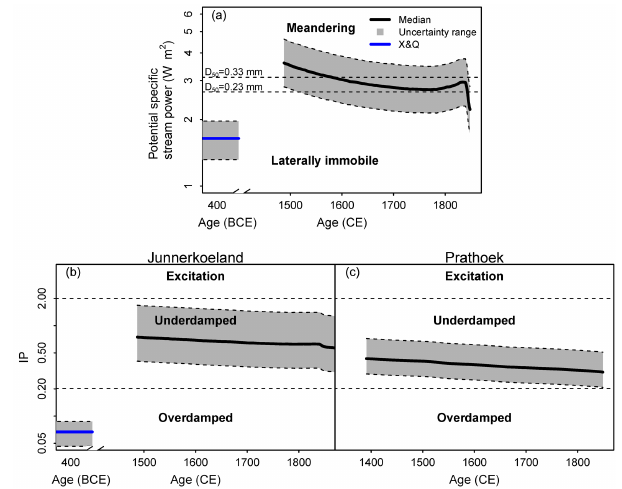
Figure 11. The potential for meandering with time. (a) The po- tential specific stream power in a stability diagram (Eq. 11). Two discriminators were plotted for a range of median particle sizes of the bed sediment, which is the range of particle sizes found in the scroll bars and Palaeochannels X and Q (Fig. 6). Panels (b) and (c) show the bar regime for both Junnerkoeland and Prathoek, de- termined with the interaction parameter (IP) (Eq. 18) and compared to the thresholds (Eqs. 19 and 20). Shading indicates the 16th and 84th quantile. X & Q refers to Palaeochannels X and Q